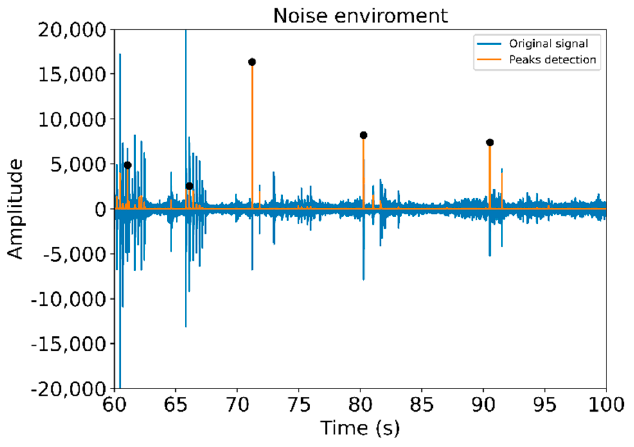
Figure 15. 40 seconds audio sample and its corresponding peak detection. Figure 15. 40 s audio sample and its corresponding peak